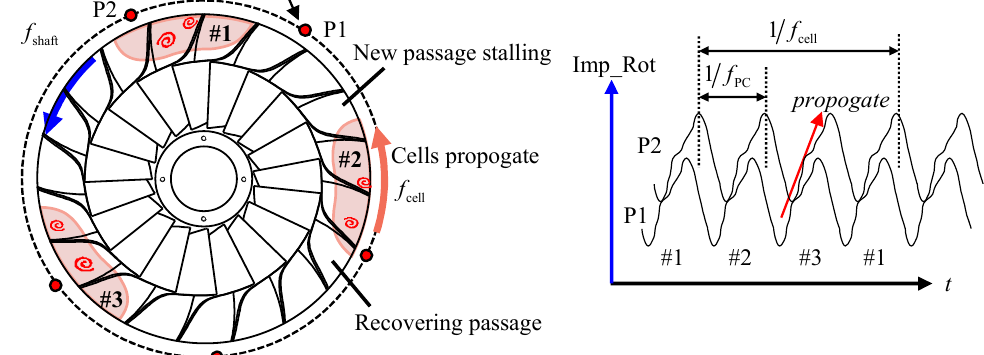
Figure 1. Dynamic characteristics of rotating stall in a centrifugal compressor impeller.